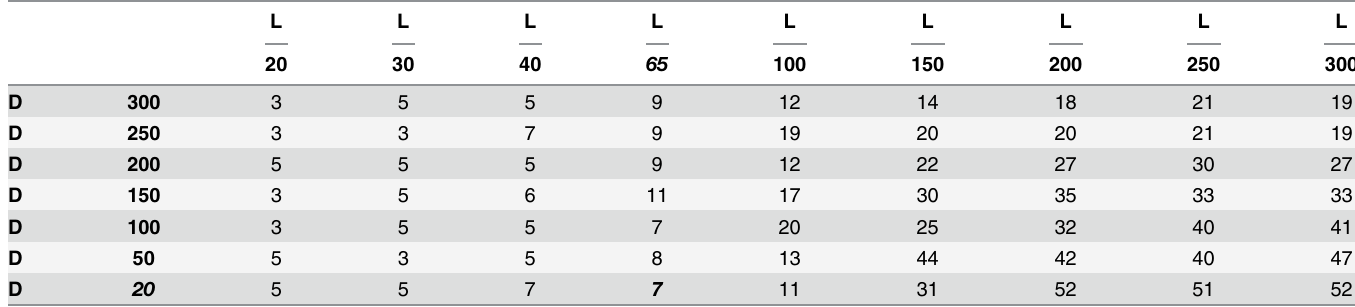
Table 1. Simulation results for a 5,000-ms period at 500 photons/s and a threshold of 6. The average values over 6 trials are given. L indicates L window , D indicates D window